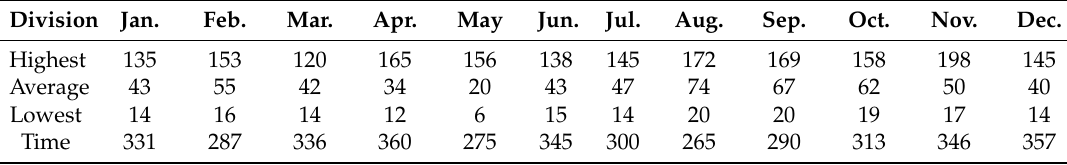
Table 4. Analysis of status of heat storage system operation (unit: Gcal/h). Division Jan.